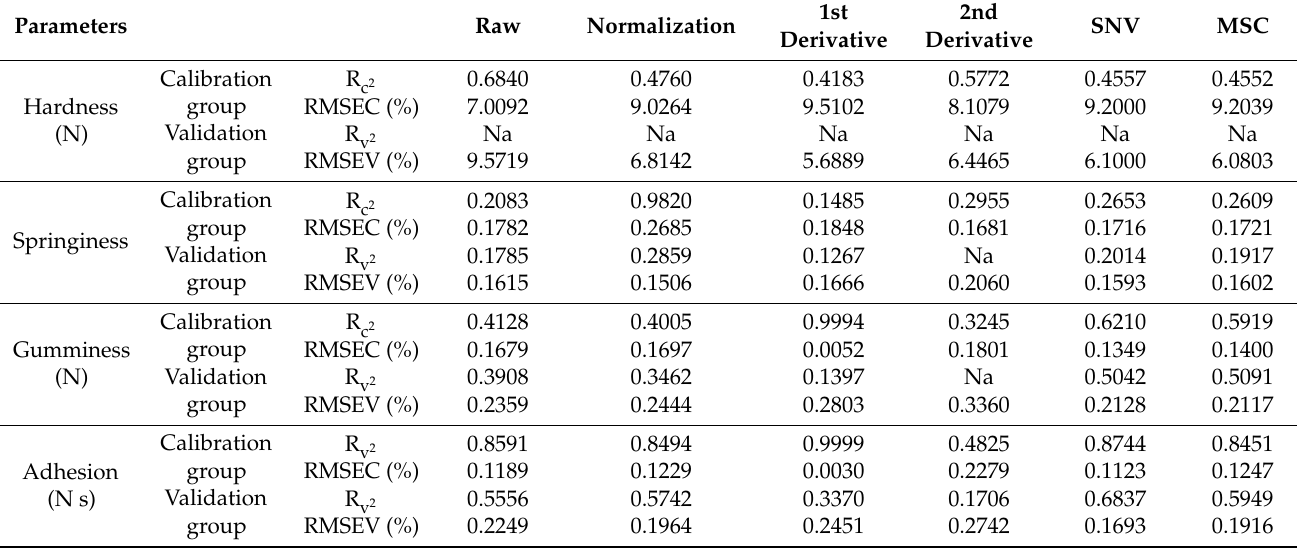
Table 5. Calibration and validation statistics for predicting textural attributes of sausage core using PLSR with full wavelengths